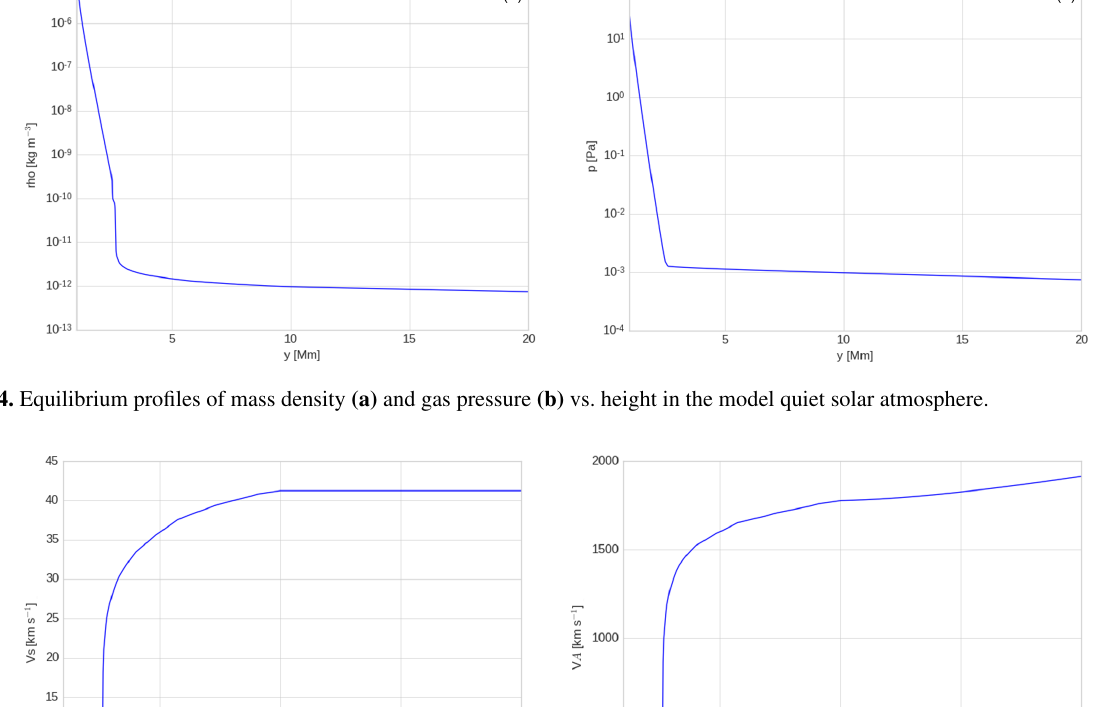
their smooth extension into the inner corona. Their